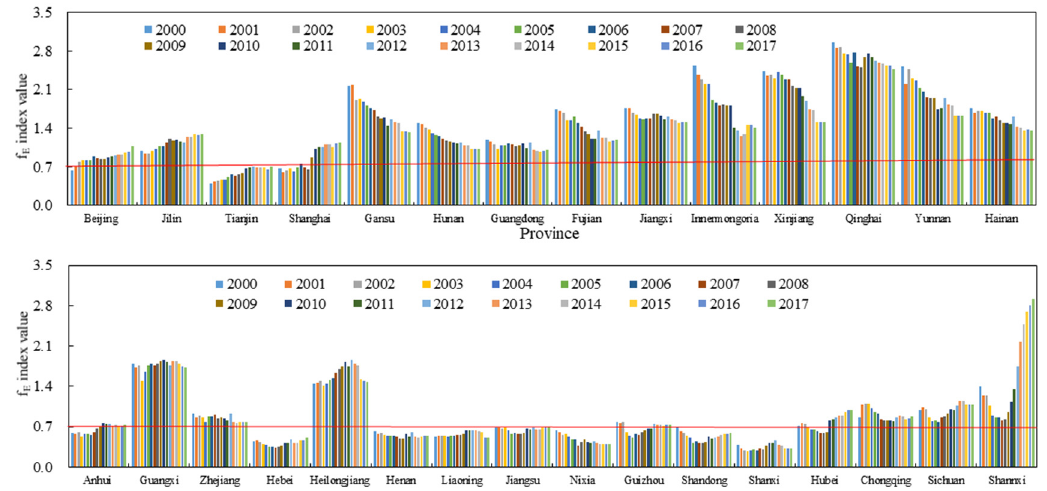
Figure 5. f E values of China’s carbon emissions from 2000 to 2017.